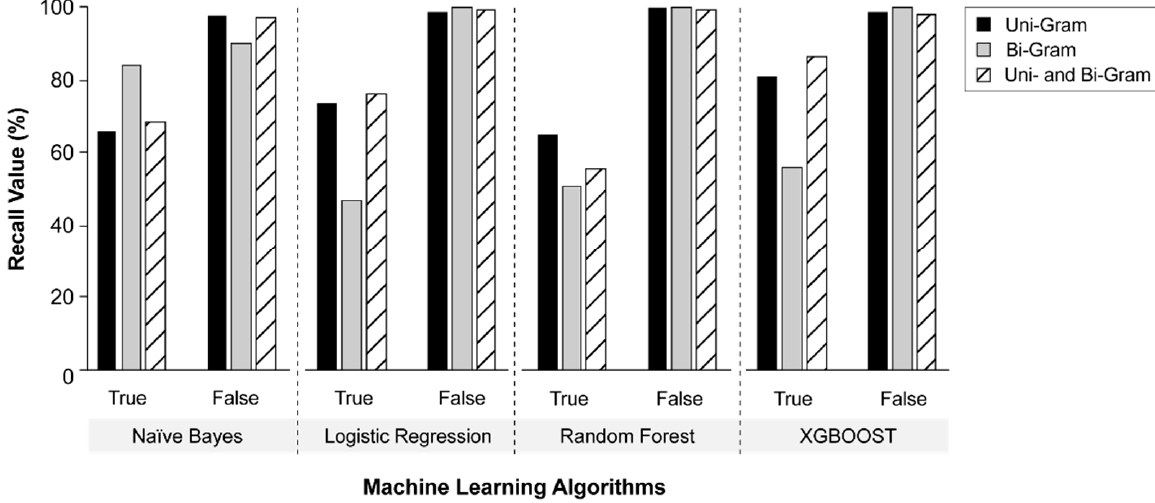
Figure 10. Impact of n-gram sets on recall performance of machine learning models. Table 3. Effect of fine-tuning hyperparameters on performance metrics of Random Forest (RF) and Extreme Gradient Boosting (XGBOOST)-based